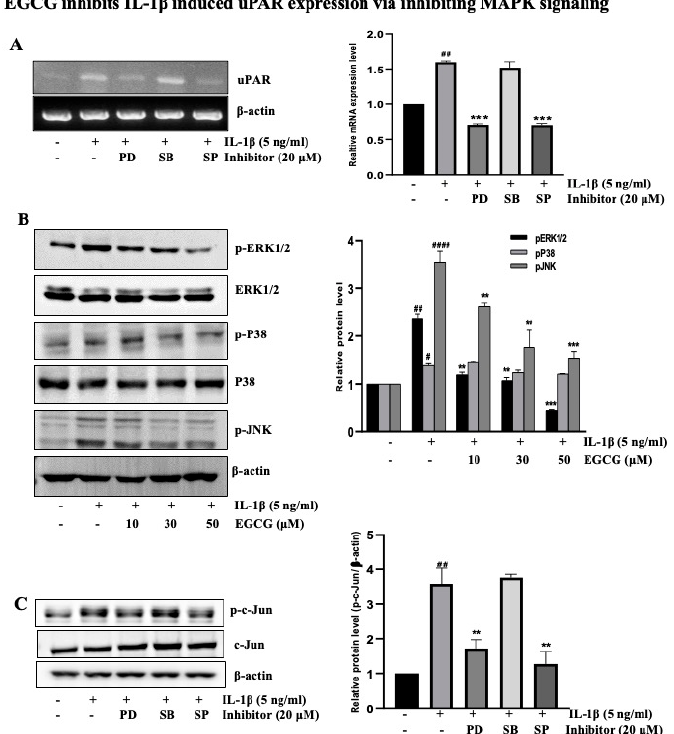
Figure 3. EGCG inhibits MAPK signaling stimulated by IL-1 β in T24 bladder cancer cells ( A ) RT-PCR analysis to detect the uPAR expression by 1 h pretreatment with signaling inhibitor and then 5 ng/mL IL-1 β treatment for 4 h. ( B ) T24 cells pretreated with 10–50 µ M EGCG for 1 h were exposed to 5 ng/mL IL-1 β for 30 min. The cells were then extracted for protein and tested for the level of phosphorylated ERK1/2, JNK and P38. ( C ) Phosphorylation of c-Jun by pre-treatment with MAPK inhibitors for 1 h were exposed to 5 ng/mL IL-1 β for 30 min. The above data represent the mean ± SD from triplicate measurements ( # p < 0.05, ## p < 0.01, #### p < 0.0001 versus control; ** p < 0.01, *** p < 0.001 versus IL-1 β